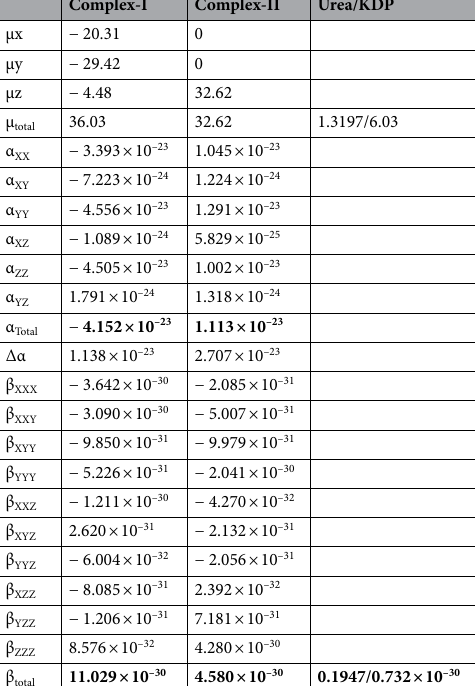
Table 3. Dipole moment (µ) in Debye (D), polarizability (α), and hyperpolarizability (β) of the titled compounds using the base level of DFT/LANL2DZ (for Co-metal)/B3LYP 6-311G** (for all atoms except Co) method. Significant values are in